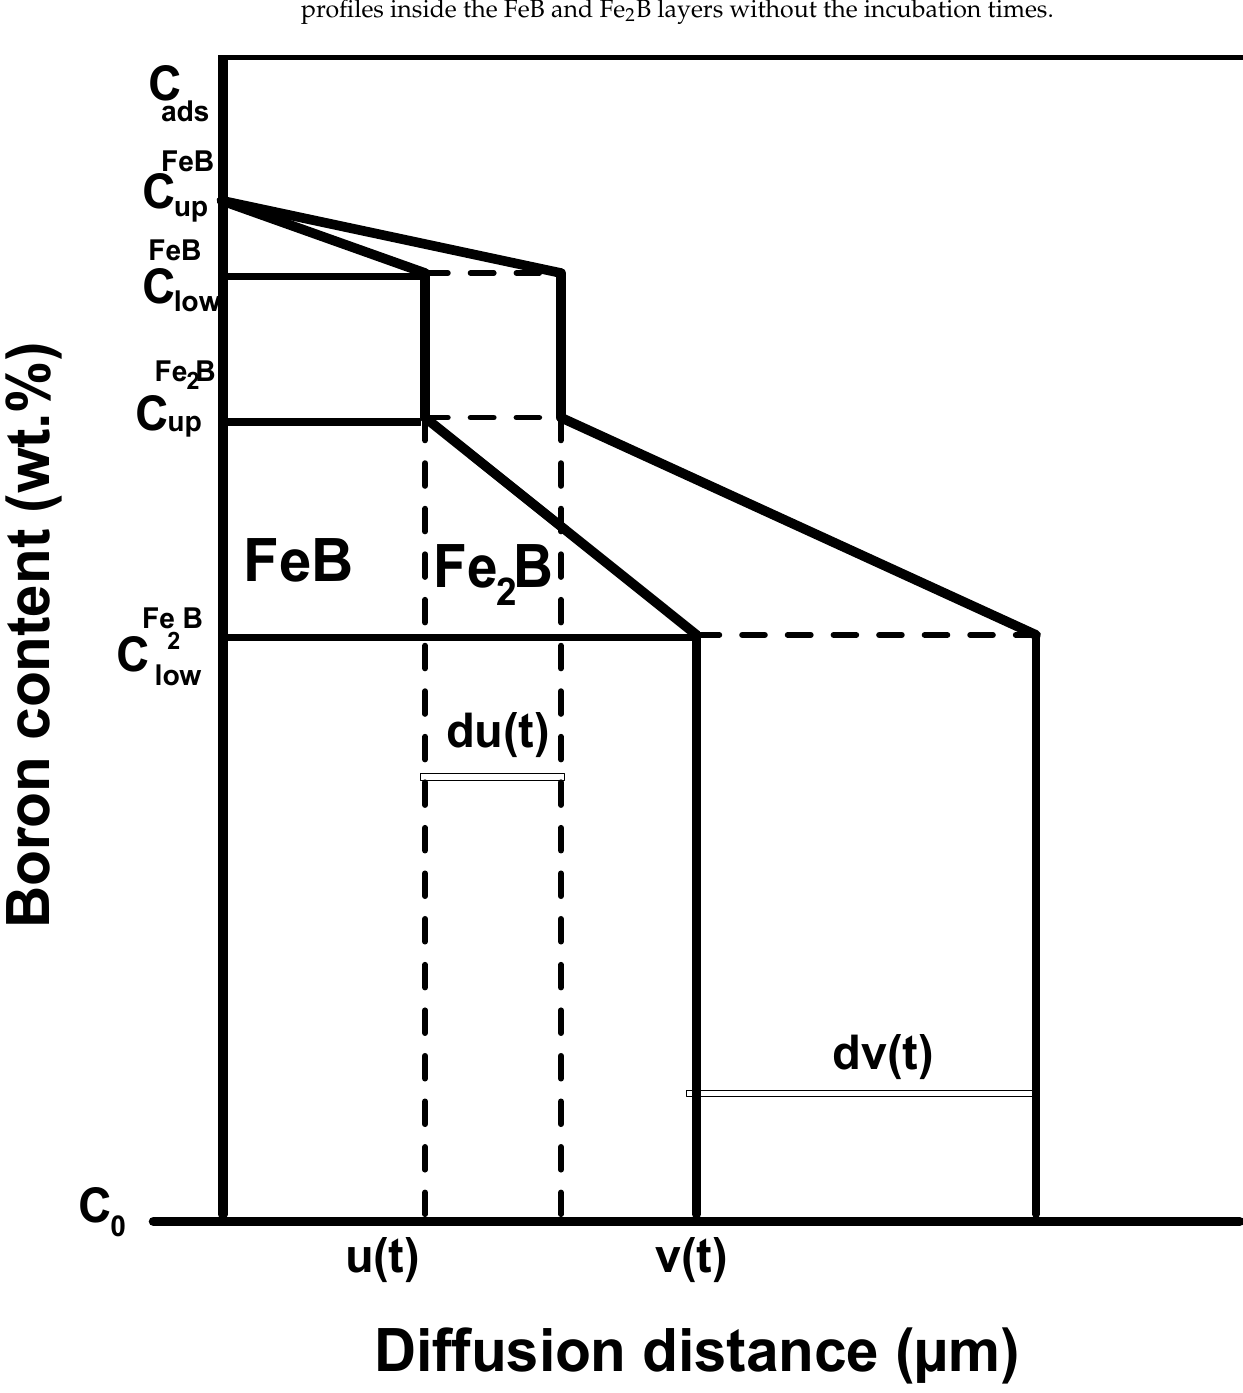
with boron atoms. Figure 11 graphically illustrates the generated boron concentration profiles inside the FeB and Fe 2 B layers without the incubation times.